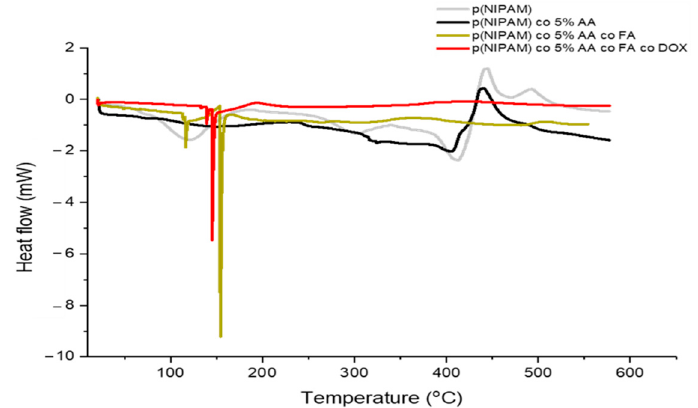
Figure 5. The DSC graph of p(NIPAM), p(NIPAM)-co-5%AA, p(NIPAM)-co-5%AA-co-FA, and p(NIPAM)-co-5%AA-co-FA-co-Dox under nitrogen atmosphere at a temperature range of rtp-600